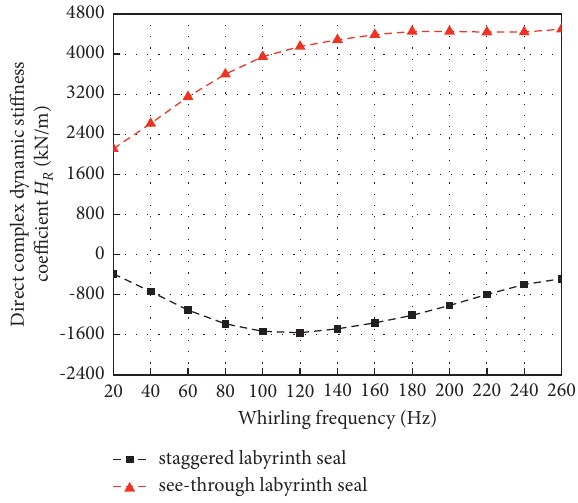
Figure 28: Direct complex dynamic stiffness coefficient vs. whirling frequency.